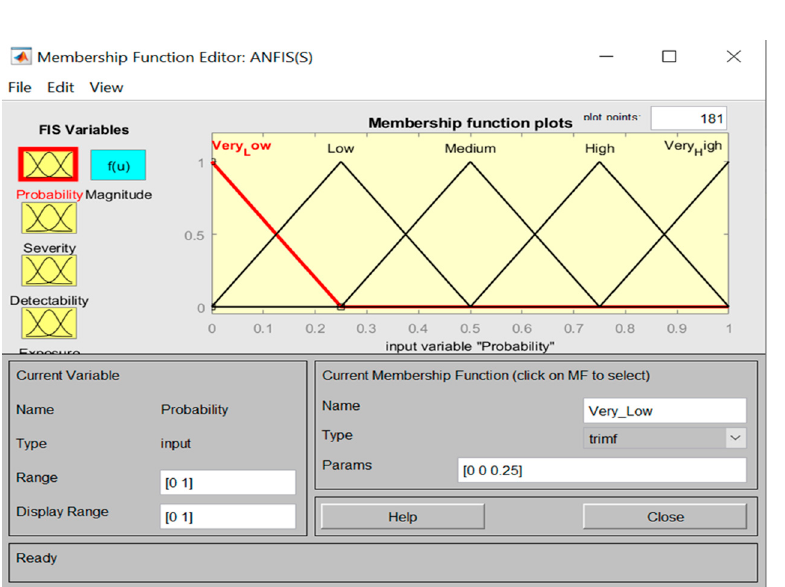
Figure 6. Inputs and output in ANFIS.